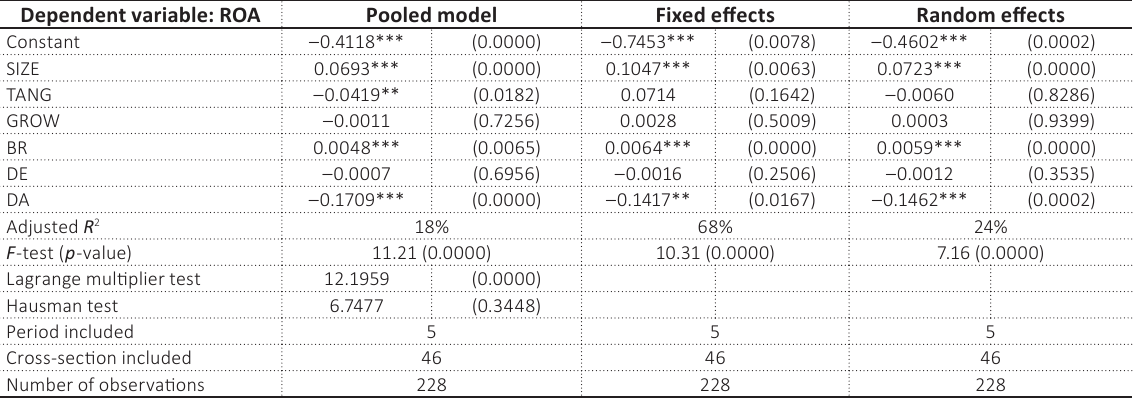
Table 7. Ordinary least squares regression results Dependent variable: ROA Pooled model Fixed